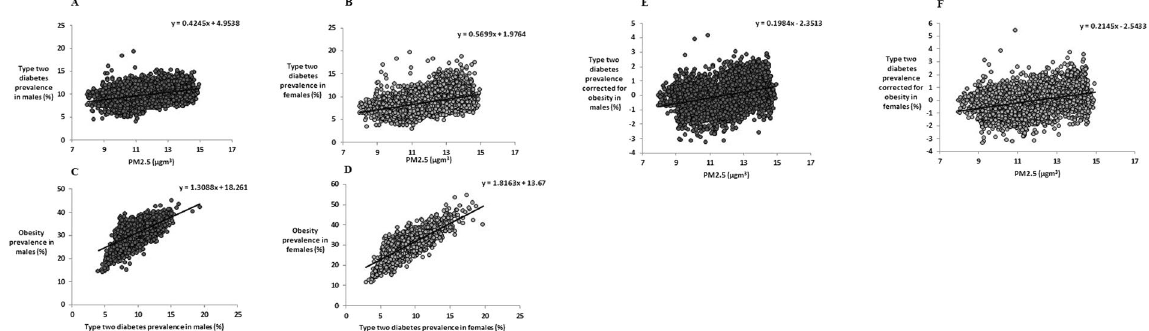
Figure 2. Association between levels of T2D prevalence for each sex and PM2.5 across the mainland USA. ( A ) T2D prevalence and average PM2.5 ( µ g.m − 3 ) for males, ( B ) T2D prevalence and average PM2.5 ( µ g.m − 3 ) for females, ( C ) association between T2D prevalence and obesity prevalence for males and ( D ) association between T2D prevalence and obesity prevalence for females and ( E ) the association between T2D prevalence corrected for obesity and average PM2.5 ( µ g.m − 3 ) for males, ( F ) the association between T2D prevalence corrected for obesity and average PM2.5 ( µ g.m − 3 ) for females.